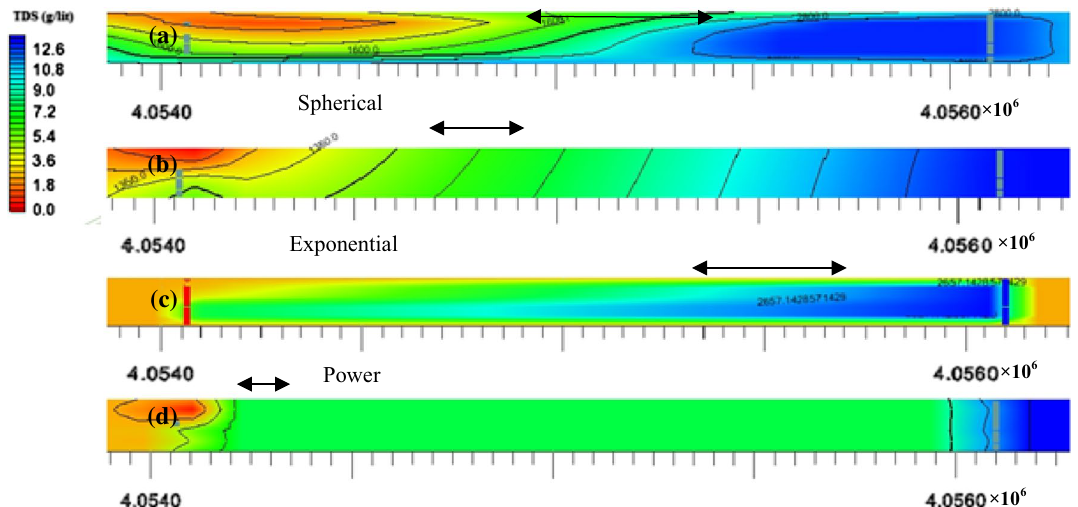
Fig. 10 Vertical profile of saltwater intrusion for different